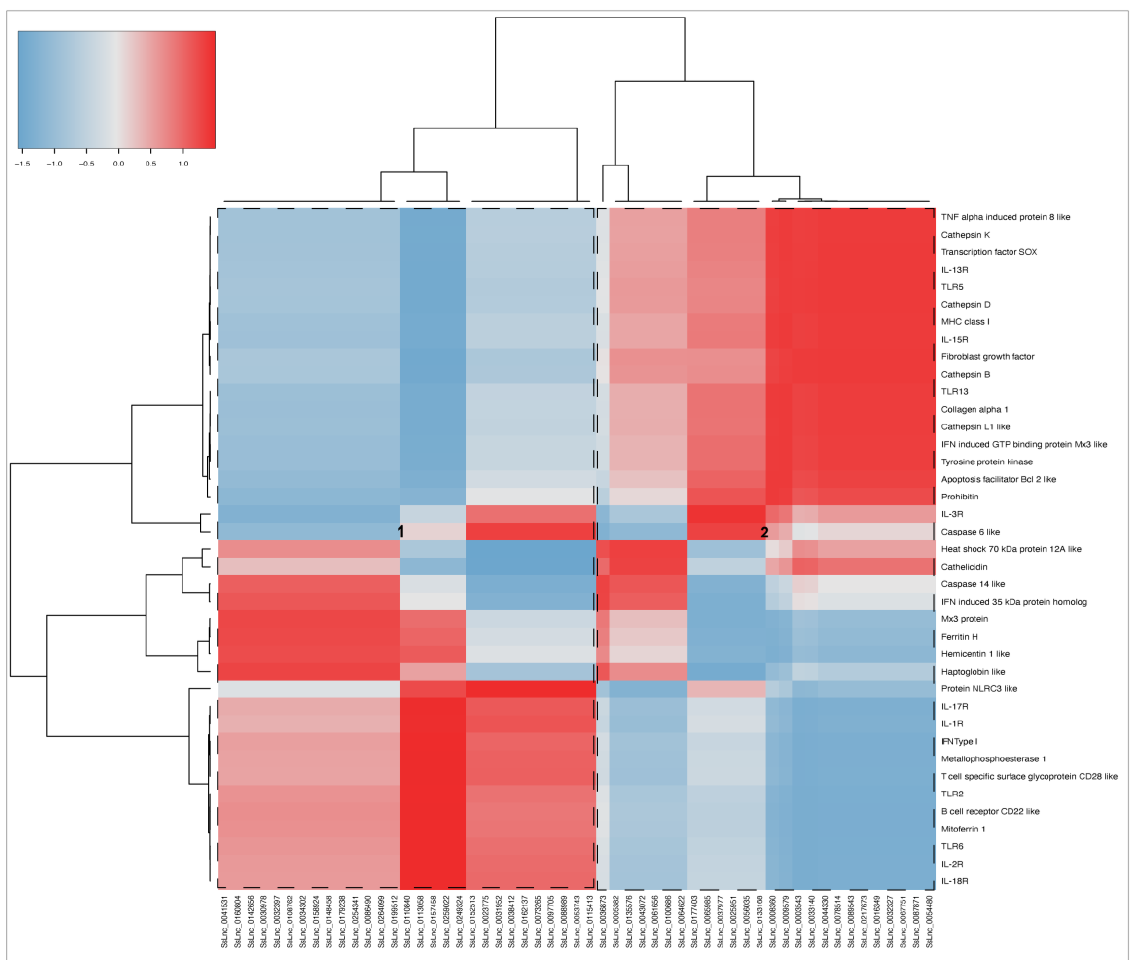
Figure 6. Correlation analyses among the top 55 upregulated shared lncRNA and selected coding transcripts related with immune response, iron homeostasis, and transcription factors. The correlation matrix was based on Pearson’s correlation calculation using transcript fold change values. Positive correlations of expression levels are represented in red, and negative correlations are represented in blue.